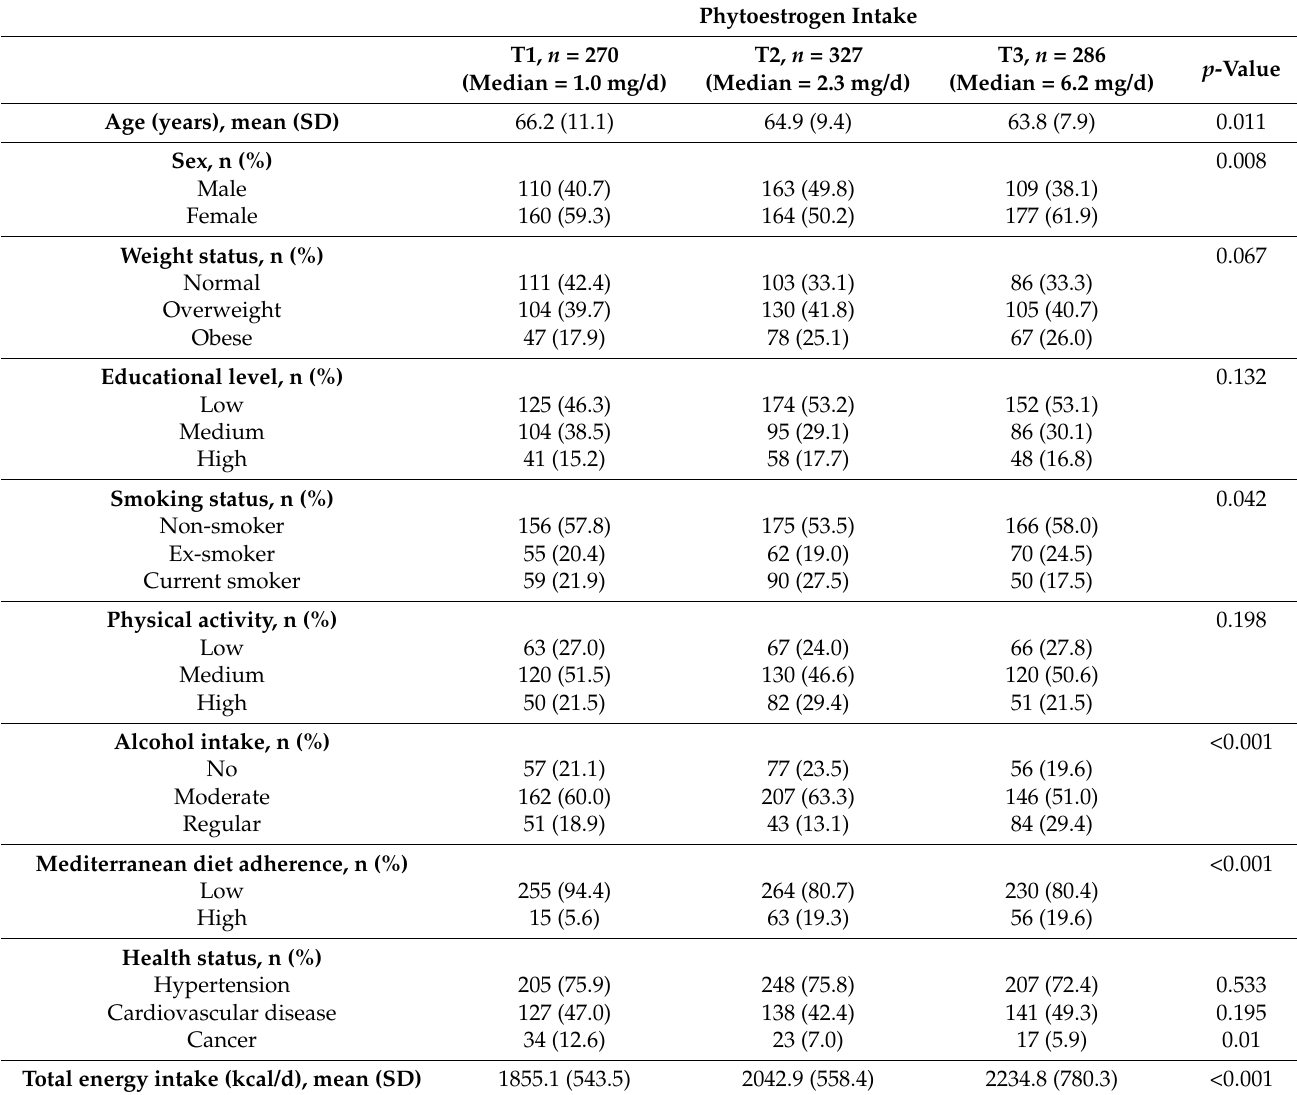
Table 1. Background characteristics by tertiles of dietary isoflavone and lignan intake in the study sample ( n = 883).